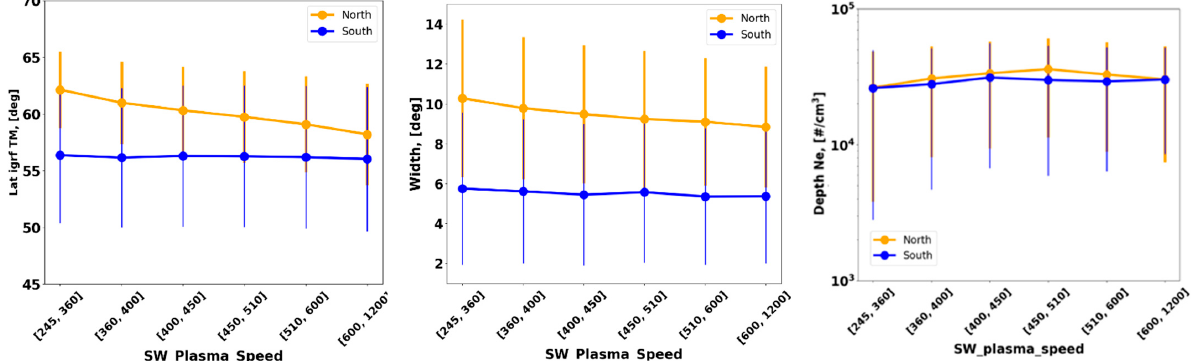
Figure 15. Solar speed dependence of the trough minimum position, trough width, and trough depth for the northern and southern hemispheres.